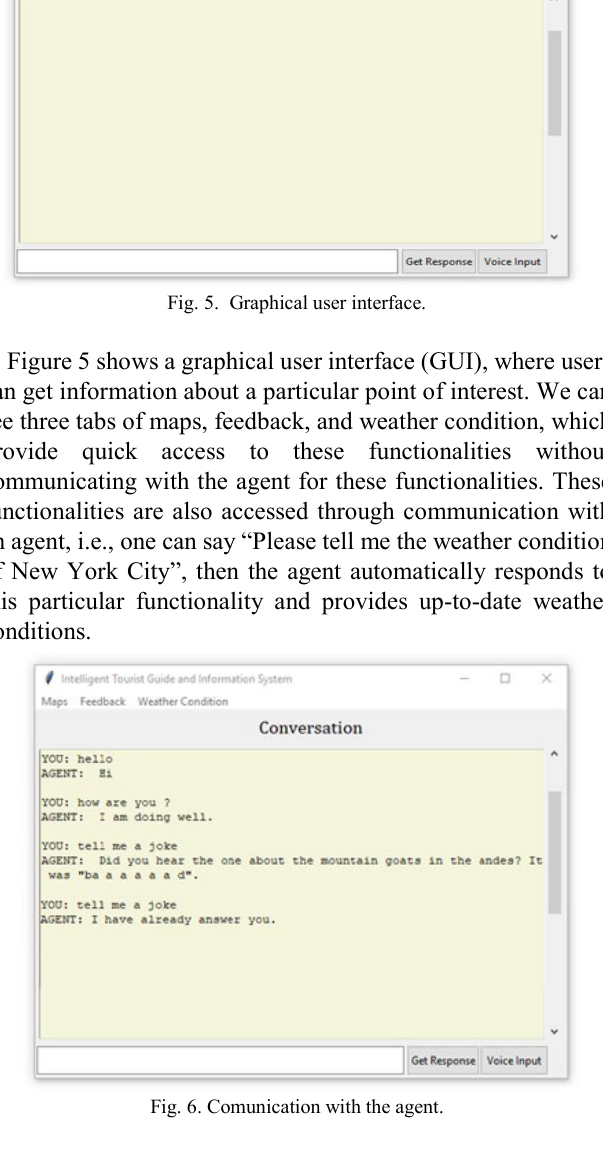
Fig. 9. Learning process and priority update by the